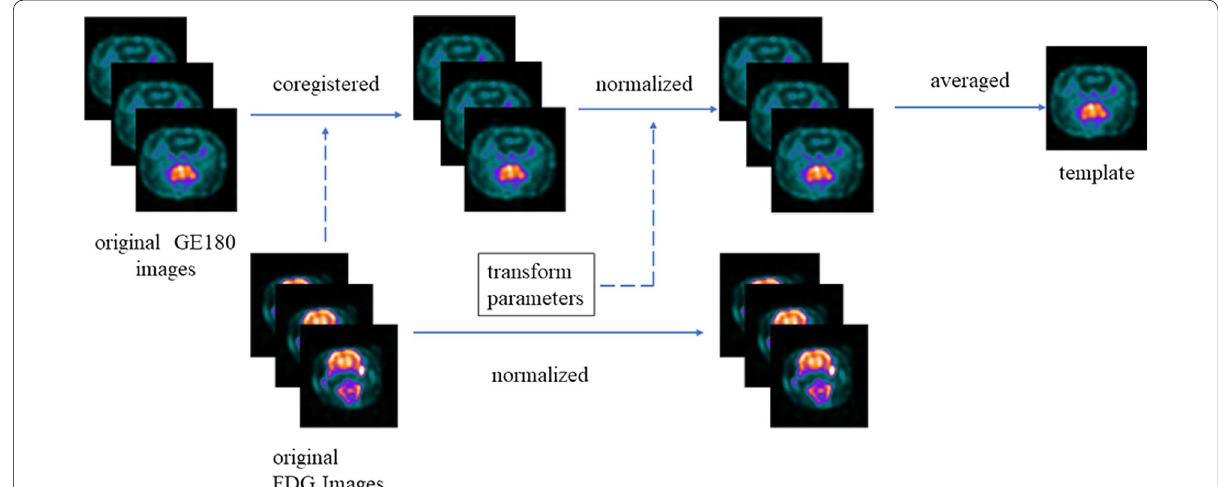
Fig. 1 Flowchart for 18 F-GE180 template construction. The solid arrows represent the following procedure, while the dashed arrows indicate the target for coregistration and special normalization. All of the steps were repeated only once